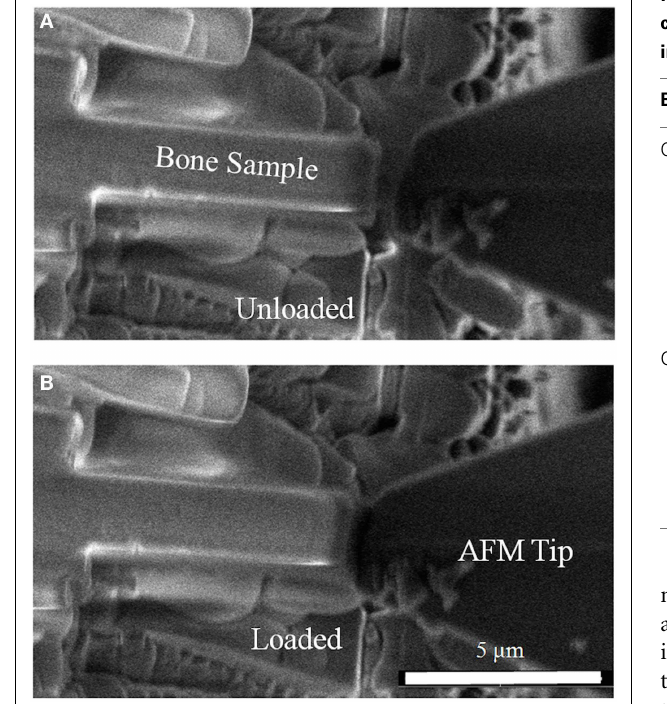
FIGURE 2 | Scanning electron micrograph showing compression of rat bone micro-beams (A) in the unloaded state with theAFM tip away from the bone micro-beam and (B) during contact of theAFM tip with the bone micro-beam causing compressive loading .